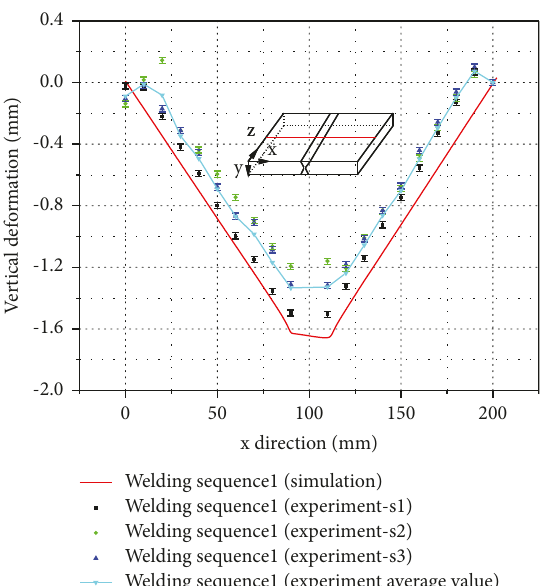
Figure 12: Comparison of measured and simulated values of vertical